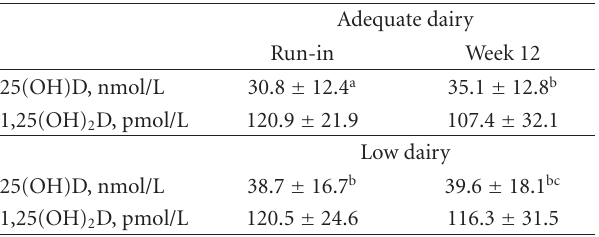
Values are mean + standard deviation. Di ff erent superscripts denote significant di ff erence between treatment groups ( P = 0 . 02) and over time ( P = 0 .